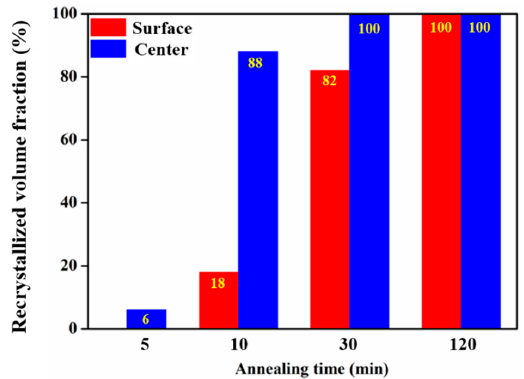
Figure 7. Recrystallization volume fraction of 70% clock-rolled Ta in the surface and center layers when annealed at 1050 °C for different